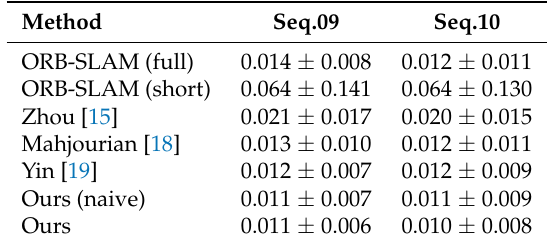
Table 7. Absolute Trajectory Error (ATE) on KITTI odometry Dataset. The results of other baselines are taken from